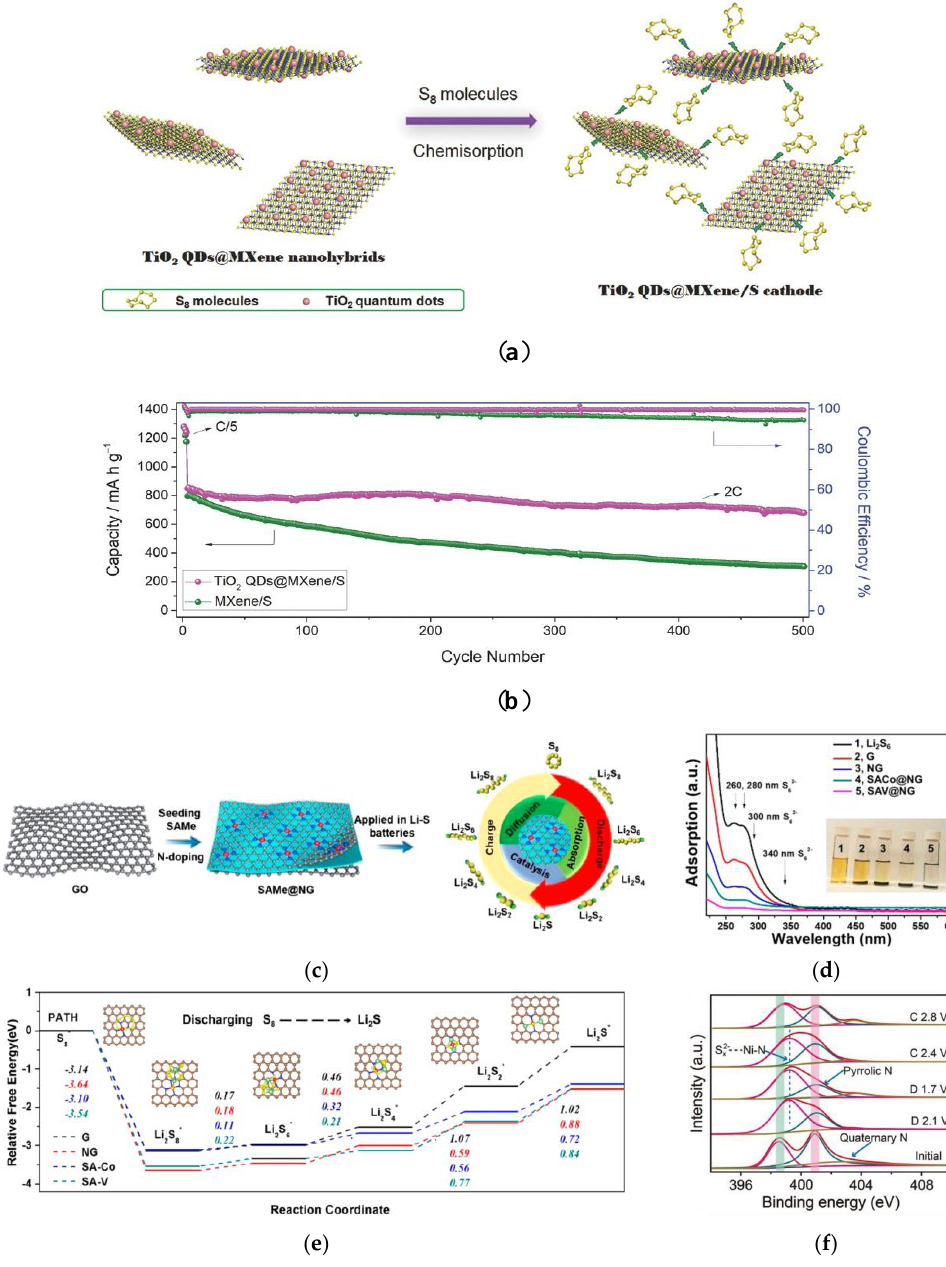
Figure 9. ( a ) Schematic configuration of the assembled Li-S cell model and the electrochemical improvement mechanism of the macro / meso Co-N-C-decorated separator [75]. ( b ) The scheme of rational design of 3D Co / NCNS / CNT as separator coatings for high-performance Li-S battery [75]. ( c ) The EIS spectra of di ff erent materials in a symmetric cell with Li 2 S 6 in the electrolyte [78]. ( d ) Schematic illustration for the synthesizing TiC nanosheets directly inlaid into the plane of graphene templates using TiCl 4 as the reactant [78]. ( e ) The polarization curves of the symmetrical cells with and without Li 2 S 6 recorded from − 1.0 to 1 V at 10 mVs − 1 [78]. ( f ) Mo 3d spectra of the Mo 2 C–C